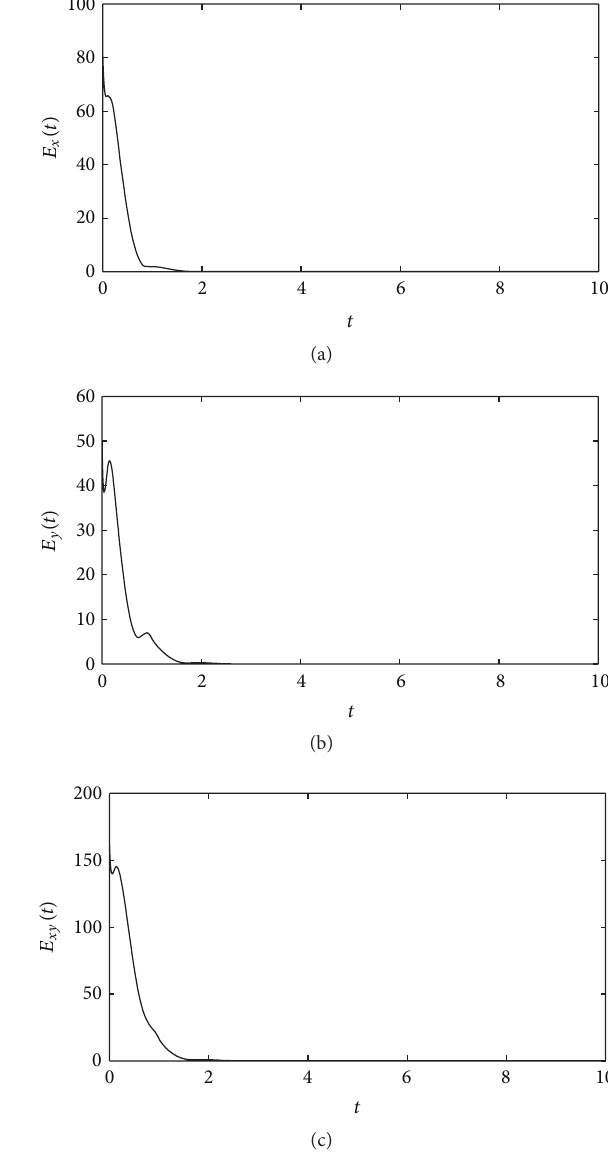
Figure 1: The trajectories evolution of the state variable, (a) 𝑥 𝑖 1 (𝑡) , (𝑡) , (b) 𝑥 𝑖 (𝑡) , 𝑦 𝑖 (𝑡) , and (c) 𝑥 𝑖 (𝑡) , 𝑦 𝑖 (𝑡)(𝑖 = 1, 2, . . . , 5) . 𝑦 𝑖 1 2 2 3 3 and the errors between nodes are defined by